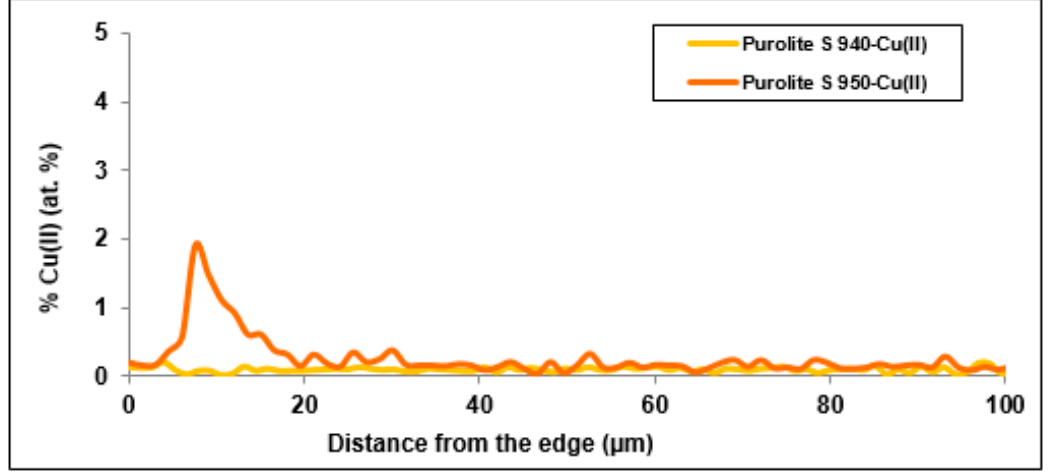
Figure 7. Distribution of the content of elements in the cut beads of Purolite S 950 after the Cu(II) ions sorption.